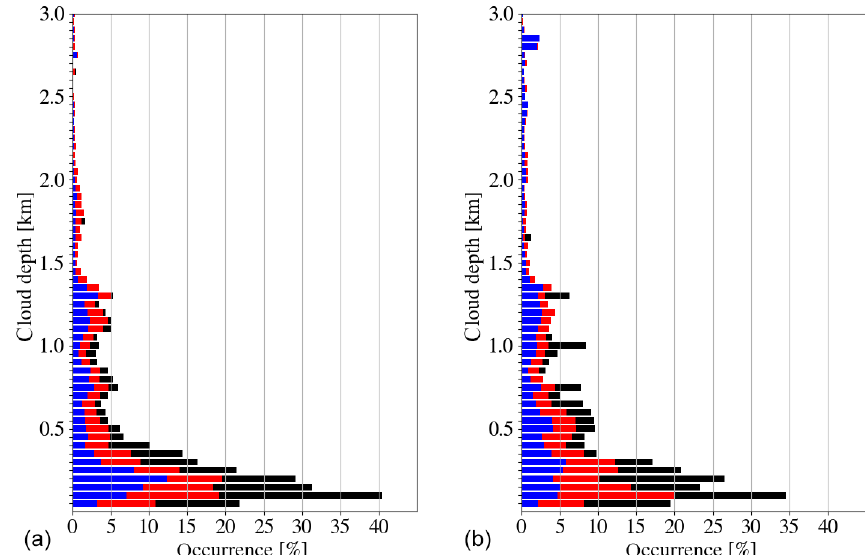
Figure 9. Cloud depth of single-layer and multilayer clouds. Blue describes the cloud depth distribution of all single-layer clouds, red describes depths of clouds with two layers, and black describes all cloud depths of clouds with three and more layers. For multilayer clouds the cloud depth of each layer is counted. The data are normalized such that all thickness bins of one type add up to 100%. (a) Sea ice surface ( > 15%); (b) ocean